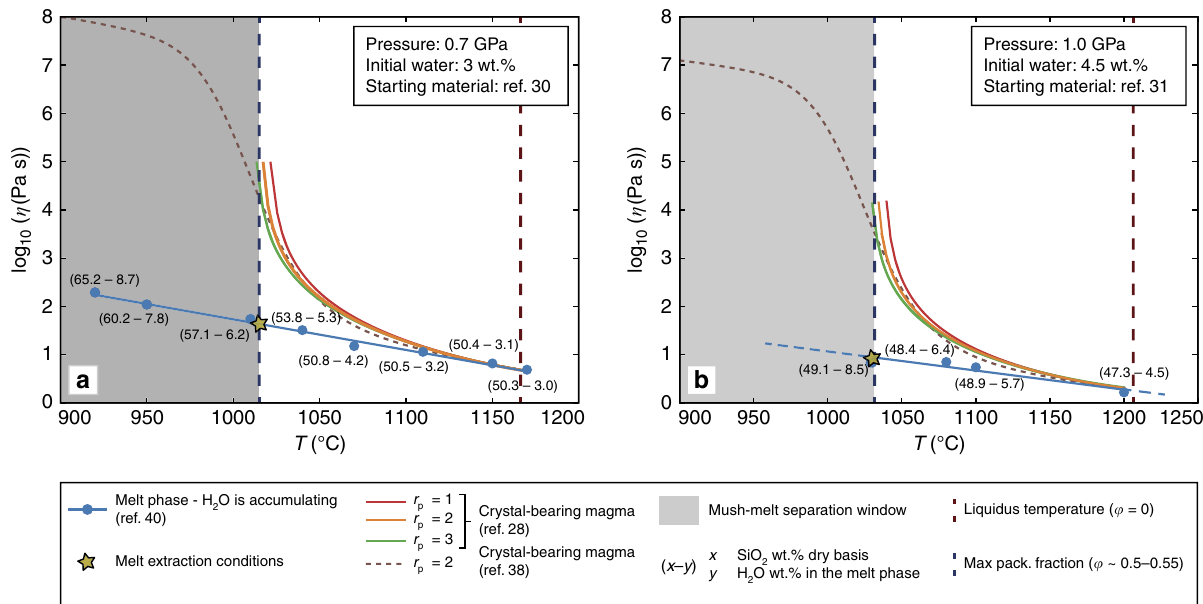
Fig. 5 Rheological evolution of the magmatic system. Temperature dependency of viscosity for crystal-bearing magma 28,37 and the residual melt 39 at pressures of a 0.7 GPa and b 1.0 GPa. The crystal-bearing magma has been modeled using the model reported by Mader et al. 28 for different aspect ratios ( r p , ranging from 1 to 3, red line for r p = 1, orange line for r p = 2, and green line for r p = 3) of the crystallizing phases. The model reported by Laumonier et al. 37 , valid for φ values up to ~0.6, is also reported for r p = 2 (brown dashed line). The evolution of the hydrous residual melt with increasing H 2 O content due to crystallization has been also reported (calculated in accordance with Giordano et al. 39 , not accounting for viscosity variations induced by pressure changes). The gray box marks the area where melt-mush separation is statistically most probable 29 . Finally, the yellow star marks the η value of the water- rich melt when the separation between the melt and the crystal-bearing magma is expected (gray